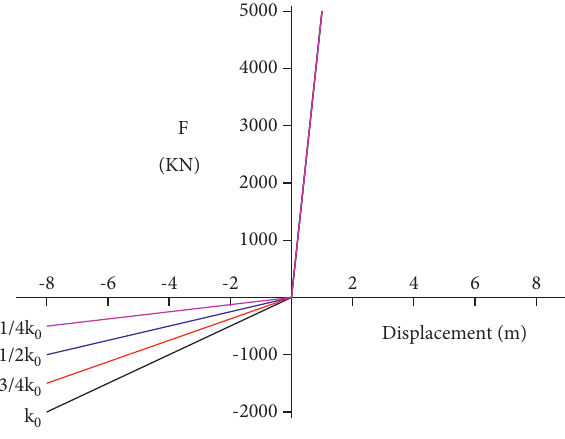
Figure 20: Joints springs stiffness.